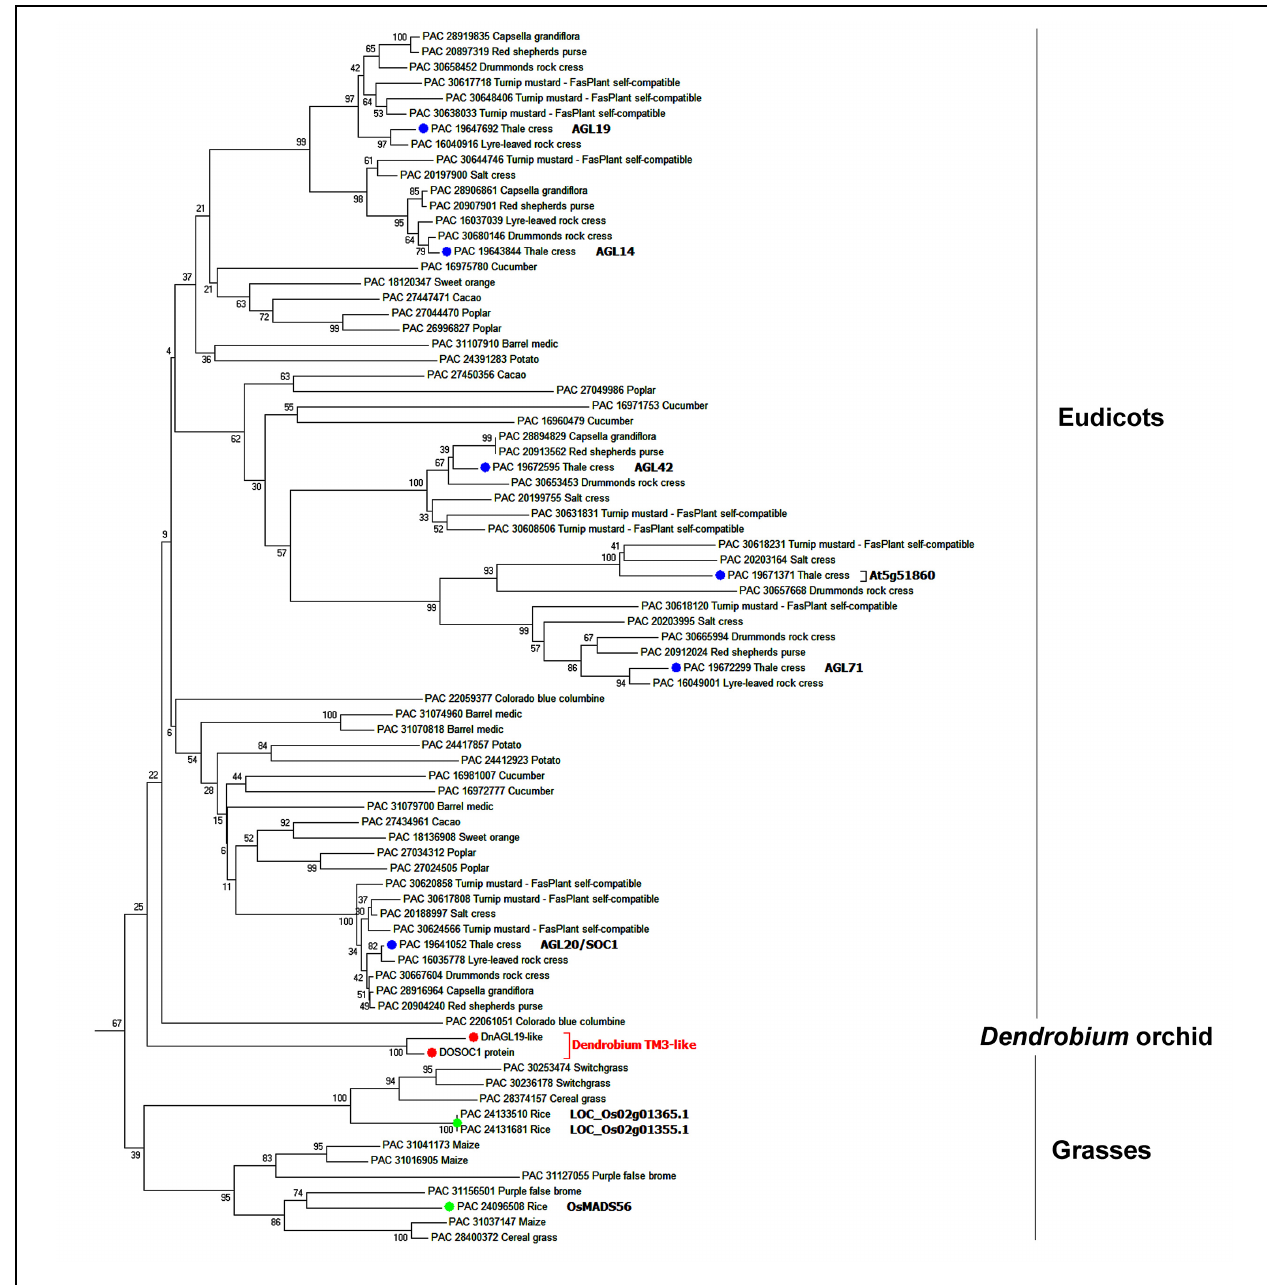
FIGURE 1 | Phylogenetic analysis of DnAGL19 and its homologs. Phylogenetic analysis of DnAGL19, DOSOC1, and homologous proteins was performed using MEGA6. A preliminary neighbor joining (NJ) tree was constructed using the Chlamydomonas reinhardtii MADS-box protein, PAC 30775785 (accession No. at Phytozome 10.2), as the out-group. The subtree containing the SOC1/TM3-like proteins is shown here. Orthologs from eudicots and monocot grasses are grouped independently, and both groups are independent from the Dendrobium SOC1/TM3-like branch (red). SOC1/TM3-like proteins from A. thaliana and rice ( Oryza sativa ) are shown in green and blue, respectively. Proteins are indicated by “Accession No. at Phytozome 10.2 + species common name.” DnAGL19 and DOSOC1 are orchid SOC1/TM3-like proteins from Dendrobium nobile and Dendrobium Chao Parya Smile,